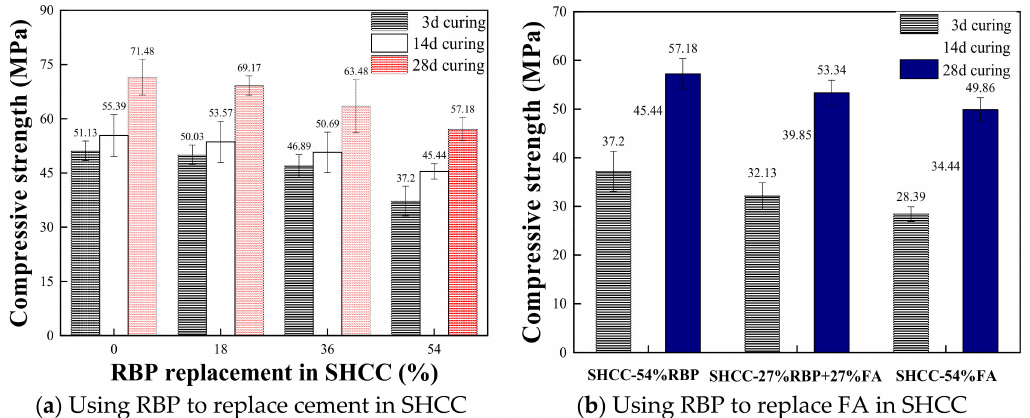
Figure 8. Compressive strength of SHCC with various RBP replacements. (Displayed values are the mean values of three measurements). ( a ) Using RBP to replace cement in SHCC; ( b ) Using RBP to replace FA in